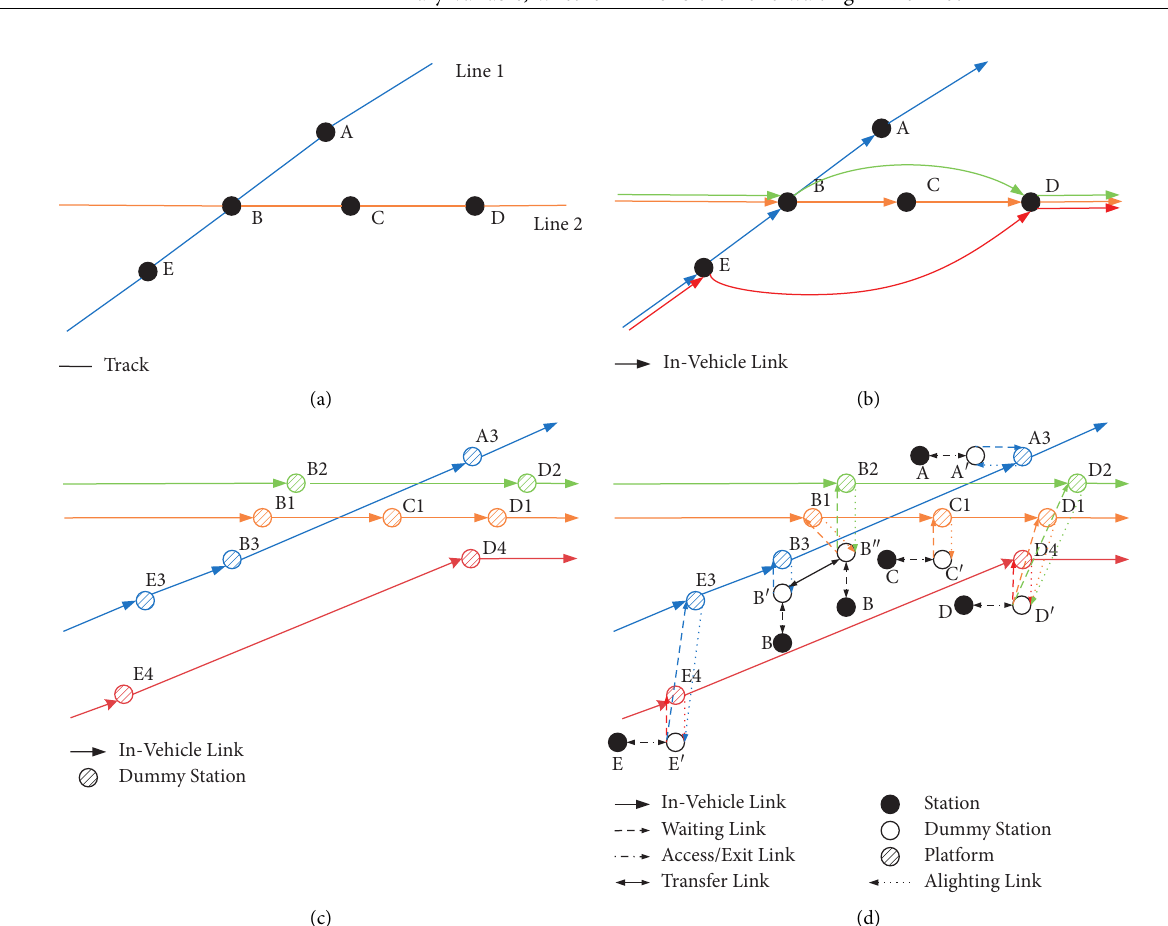
Figure 1: Transit service topology network: (a) physical network, (b) operation service, (c) frequency-based network, and (d) service